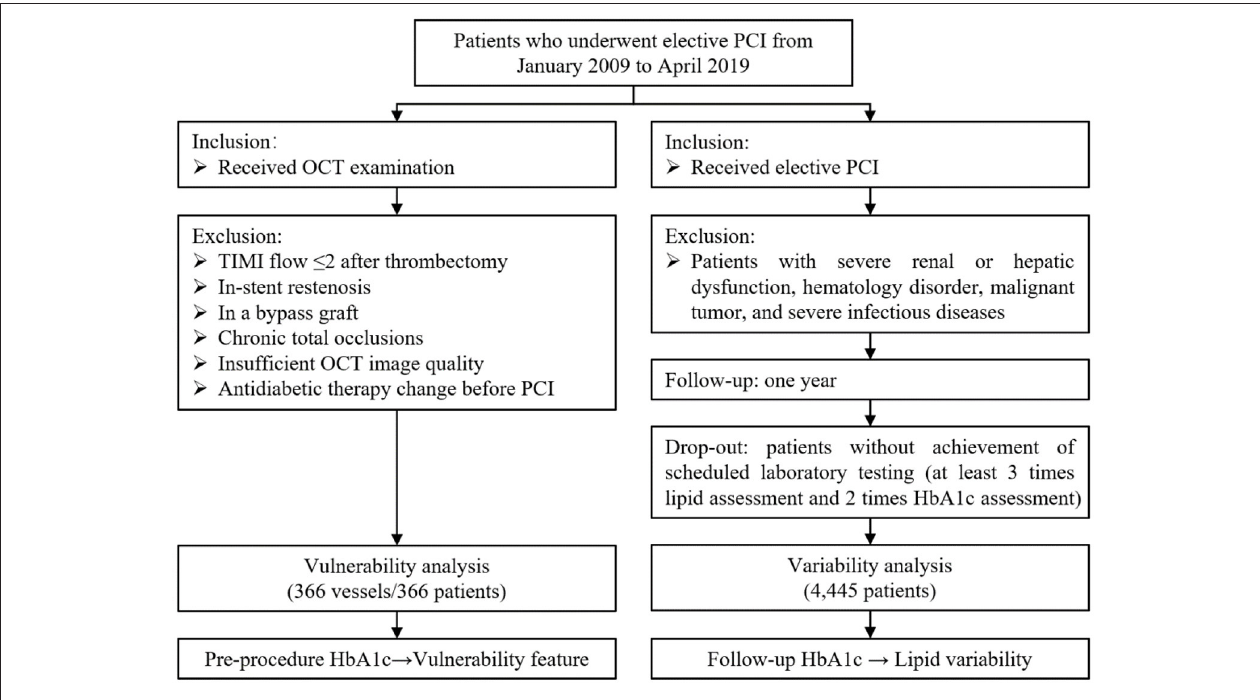
FIGURE 1 | Flow chart of the current